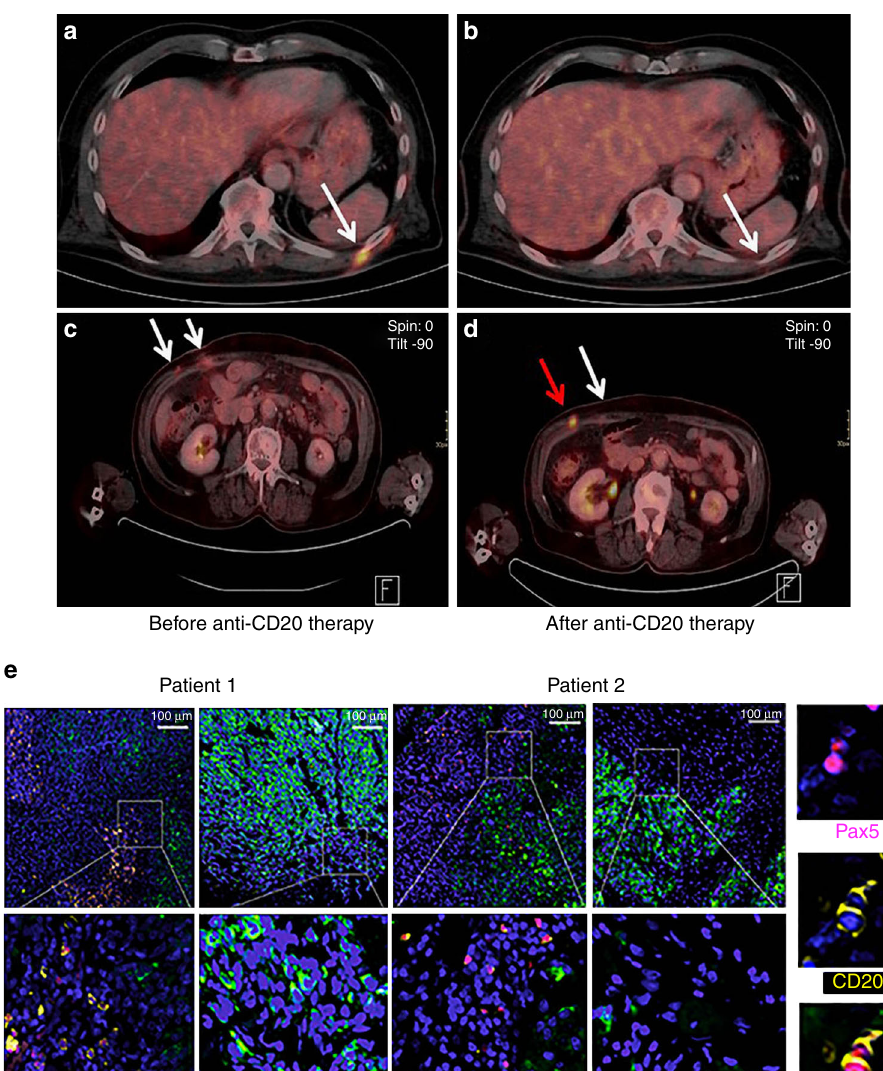
before being transferred onto polyvinylidene membranes (Millipore, Billerica, MA). Membranes were treated with primary antibodies at 1:1000 (anti-FGFR-3) or 1:2000 (anti- β actin) dilution followed by appropriate secondary anti-mouse (LICOR; 926-32220; IRDye 680LT) or anti-rabbit (LICOR; 926-32211; IRDye 800CW) antibodies (both at 1:10,000 dilution). Membranes were imaged and analyzed using an Odyssey Infrared Imaging System.